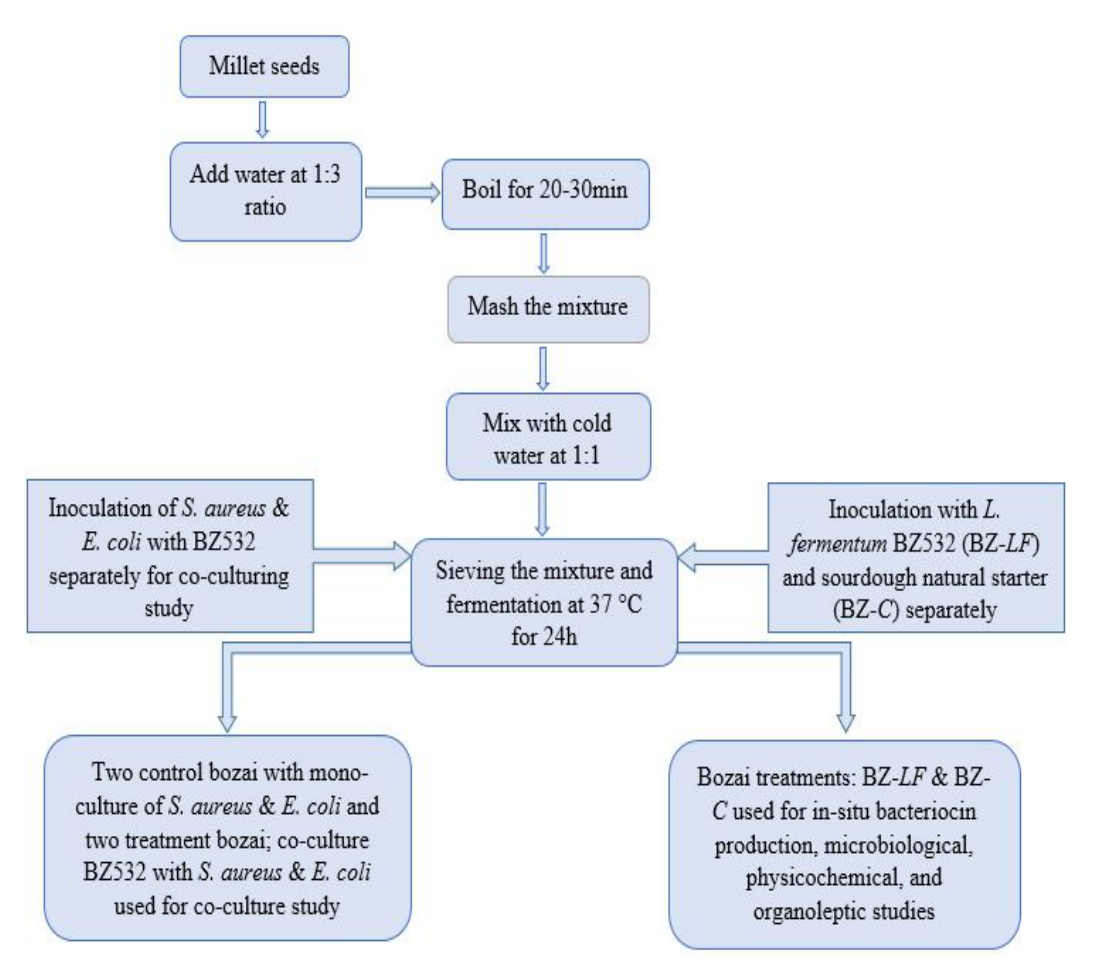
Figure 1. Flow diagram of bozai production.